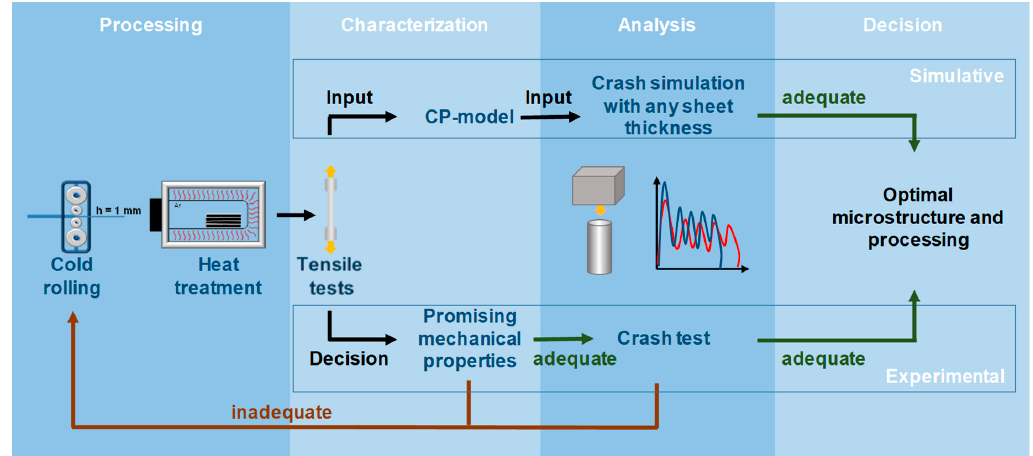
Figure 2. Schematic overview of the process chain and comparison of experimental and simulation- Figure2. Schematicoverviewoftheprocesschainandcomparisonofexperimentalandsimulation-based based design of material conditions for high manganese crash boxes. design of material conditions for high manganese crash